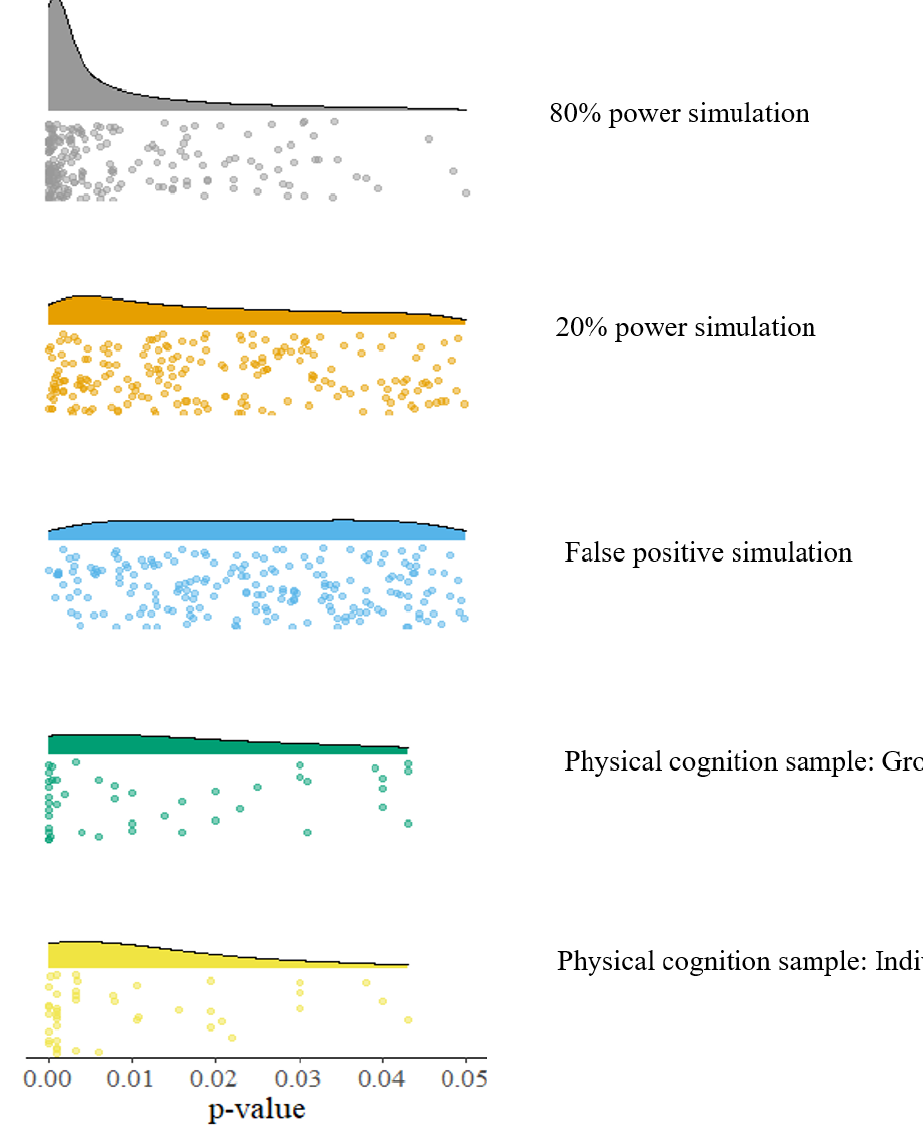
Raincloud Plot of Significant P-Values from the Alternative Statistical Inferences from Our Sample of Physical Cognition